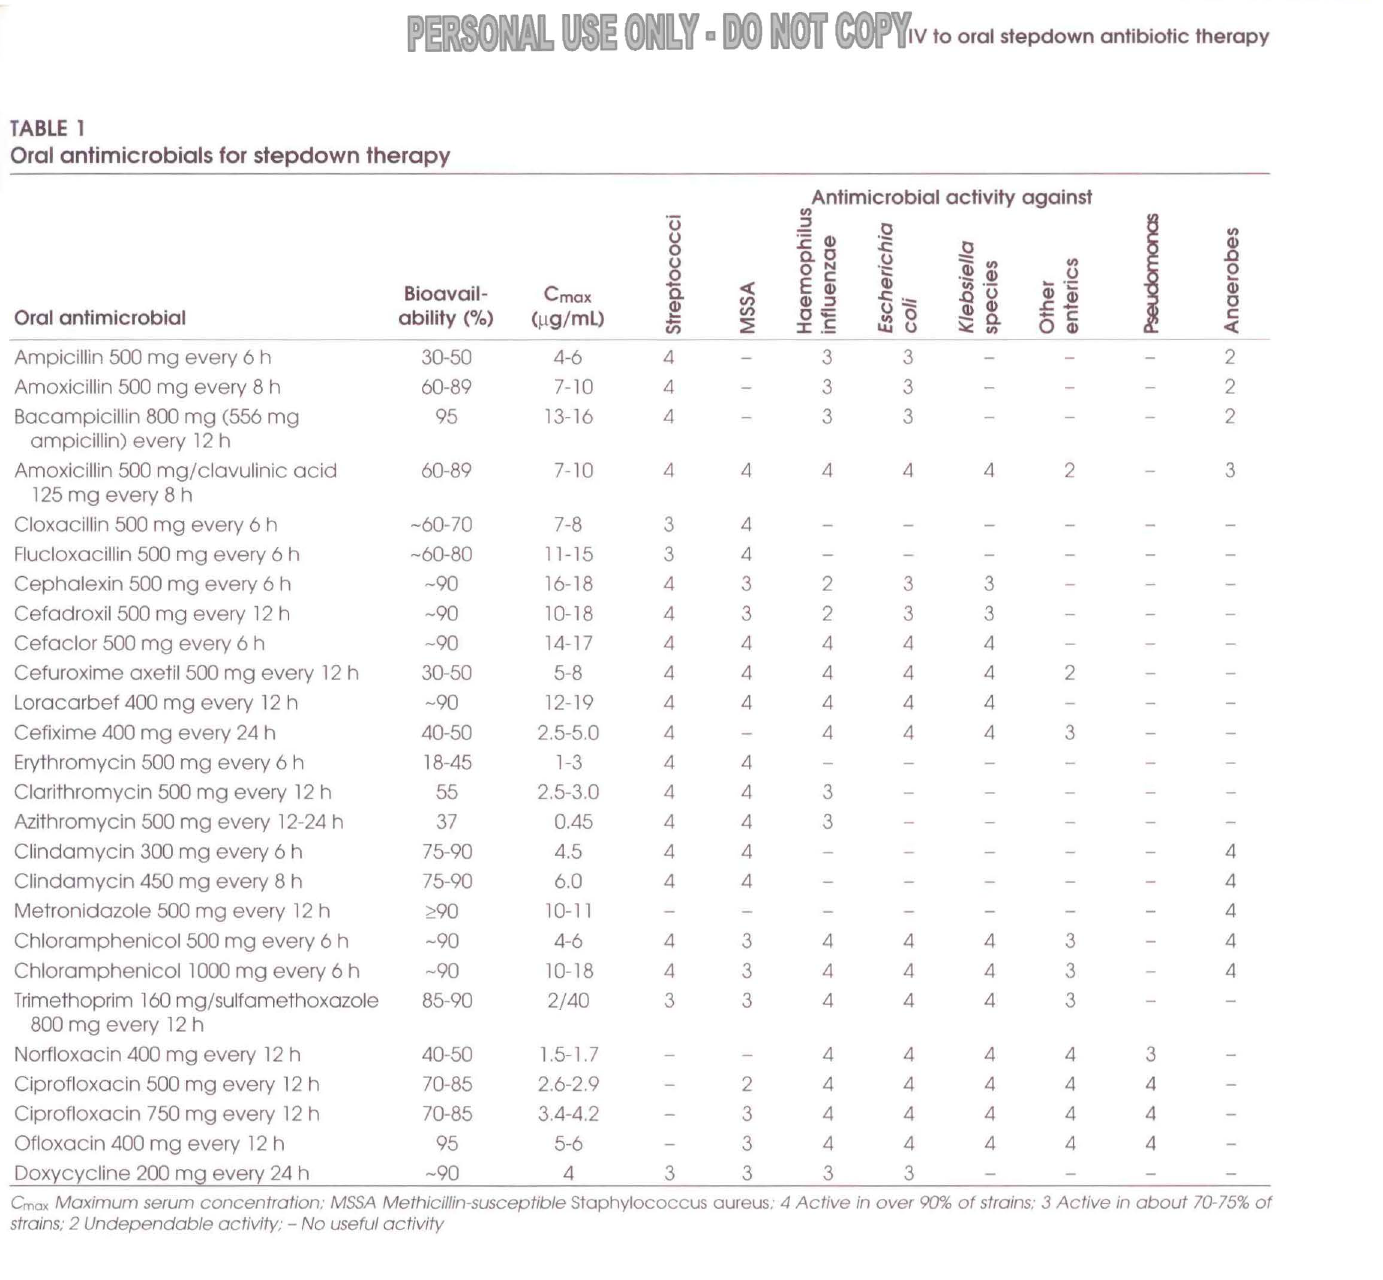
TABLE 1 Oral antimicrobials for stepdown